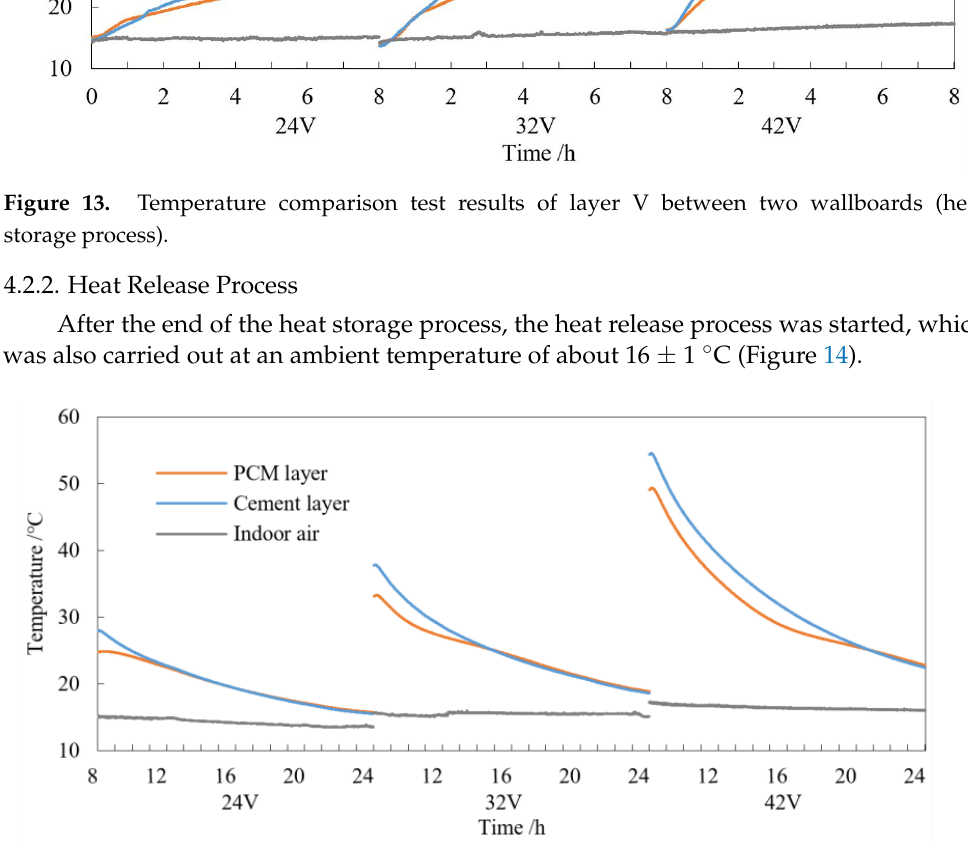
Figure 14. Temperature comparison of layer V between the two wallboards (exothermic process).